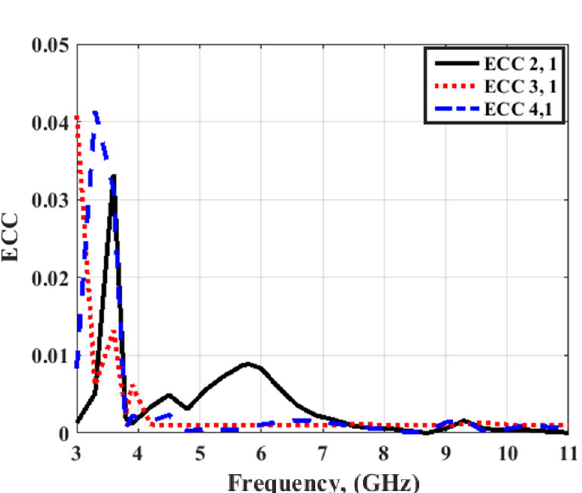
Figure 23. Port #1 ECC outcomes of the flexible MIMO antenna in bending configuration with R = 45 mm.